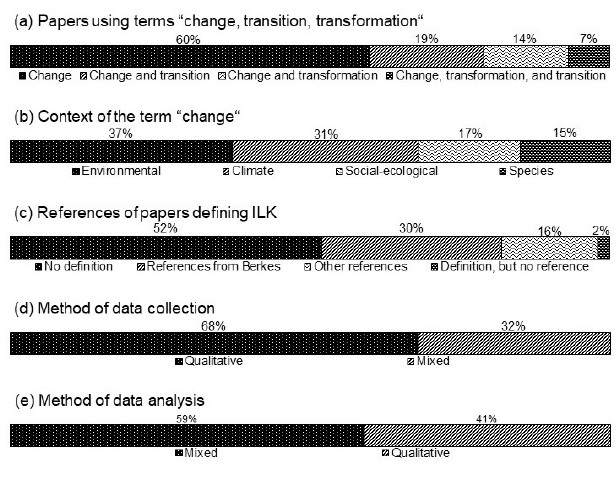
Fig. 3 . Overview of results (n = 81). Note ILK = indigenous and local